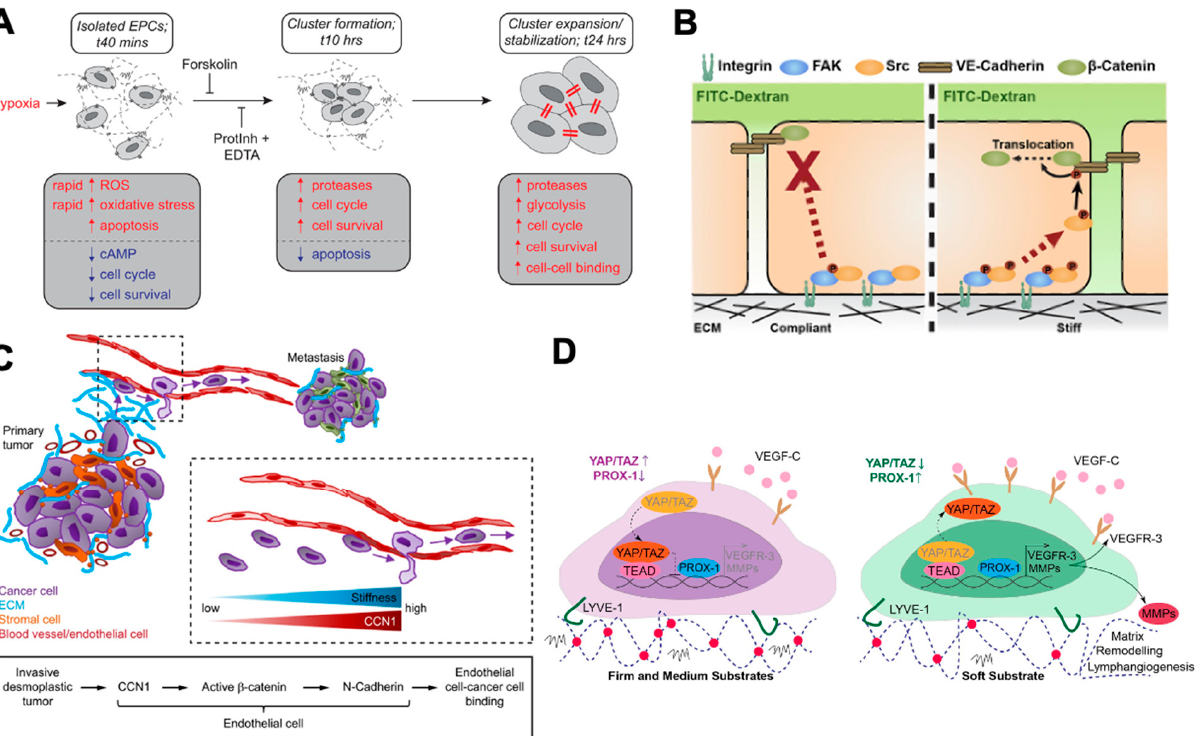
Figure 1. Engineered hydrogels for elucidating the molecular mechanisms of ECs in pathological microenvironments. ( A ). Hypoxia results in rapid ROS accumulation and triggers cAMP downreg- ulation to protect the cells from oxidative stress. Protease upregulation facilitates ECM degradation and initial cluster formation. At later time points, ECFC clusters are stabilized through increased cell–cell adhesion and upregulation of carbohydrate metabolism. The schematic was adapted from